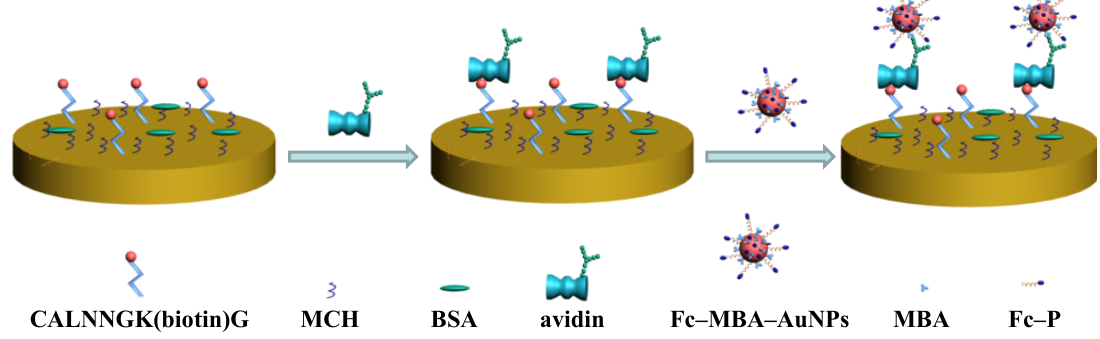
CALNNGK(biotin)G MCH BSA avidin Fc–MBA–AuNPs Fc–PMBA Figure 3. ( A ) Cyclic voltammograms (CVs); and ( B ) differential pulse voltammograms (DPVs) collected at glass carbon (GC) electrode in the solution of ferroceneboronic acid (FBA), avidin and FBA/avidin. The final concentrations of FBA and avidin were 20 and 2 μM,